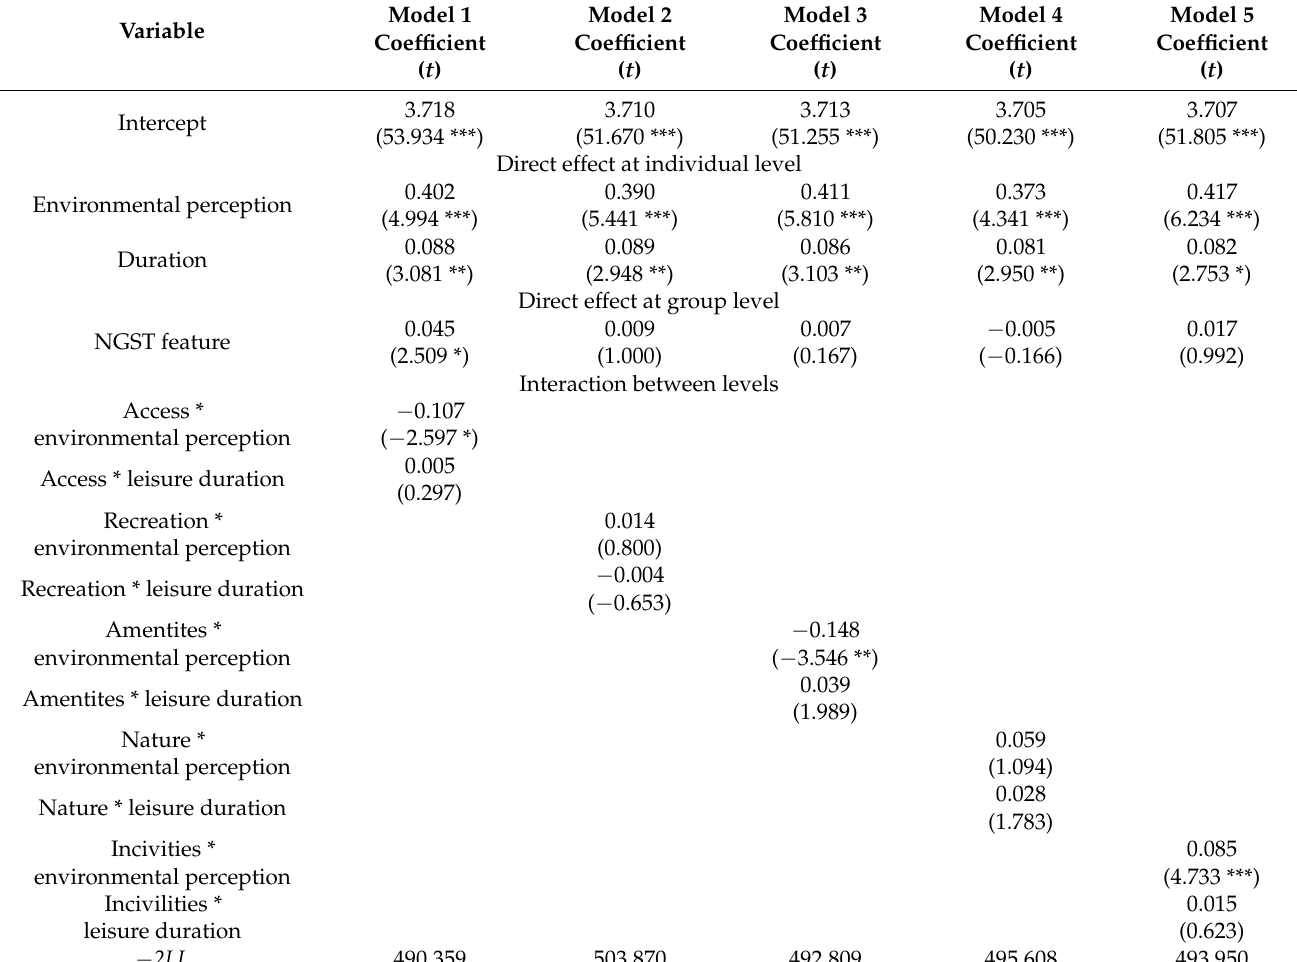
Table 6. Moderating effect of NGST for each feature of the examined model (life satisfaction as an